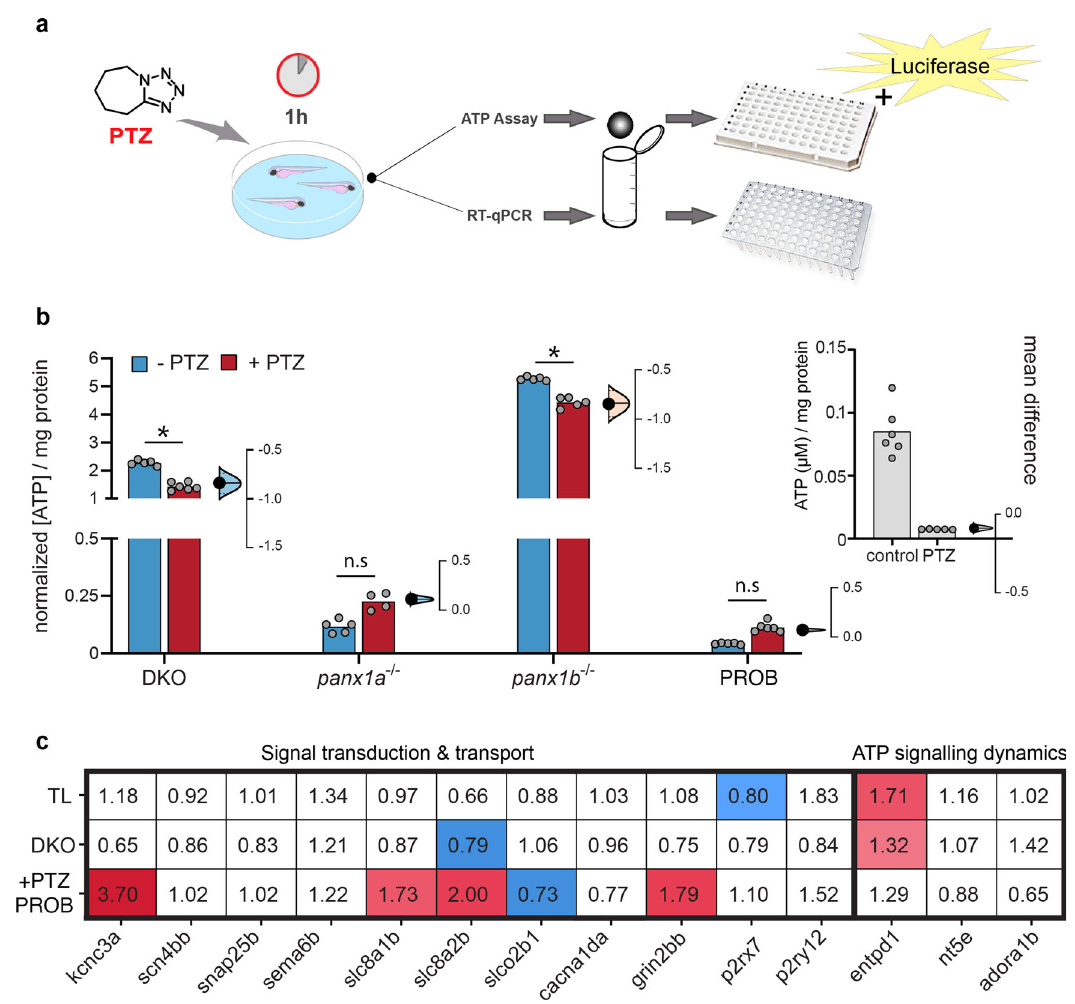
Fig. 7 Extracellular ATP is associated with a propensity for seizure-like activity. a Work fl ow diagram outlining the 1 h PTZ incubation for treated larvae. Larvae were collected for either RT-qPCR ( n = 30 larvae/sample, N = 3 experimental replicates) or ATP assays ( n = 50 larvae/sample, N = 5 experimental replicates), followed by homogenization prior to samples being plated in 96well format for measurement. Note that for ATP detection, luciferase was used. b Estimation plots of extracellular ATP concentrations ( µ M) concerning larval protein content (mg/ml) and normalized to the respective TL control. Extracellular ATP for TL controls is shown on the right ( b ), showing a signi fi cant decrease in ATP with PTZ treatment ( P = < 1.0 × 10 − 4 ). Baseline ATP values are depicted by the blue bars, PTZ treatment is in red, and individual data points are displayed in gray to show data distribution. Difference of means is shown to the right of each group, with a 95% con fi dence interval to show effect size and signi fi cance. DKO ( Δ mean = − 0.84) and panx1b − / − ( Δ mean = − 0.84) show a signi fi cant decrease in ATP with PTZ treatment. Panx1a − / − ( Δ mean = 0.1) and TL larvae with PROB ( Δ mean = 0.07) show very low ATP concentrations; however, they do show a slight increase in ATP with PTZ treatment which is not signi fi cant. Panx1b − / − has the highest presence of ATP. (DKO: P = < 1.0 × 10 − 4 ; panx1a − / − : P = 0.98; panx1b − / − : P = < 1.0 × 10 − 4 ; PROB: P = 1.0; Tukey ’ s multiple comparisons test). c RT-qPCR of selected genes grouped into signal transduction and transport, or ATP signaling dynamic categories, showing signi fi cant up (red) or down (blue) regulation, with respect to non-treated controls, in response to PTZ treatment for TL, DKO and TLs treated with PROB. ( N = 3 experimental replicates). * P < 0.0001.